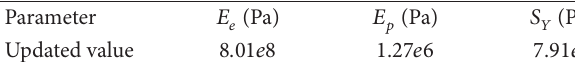
Table 4: Updated parameters of the thin